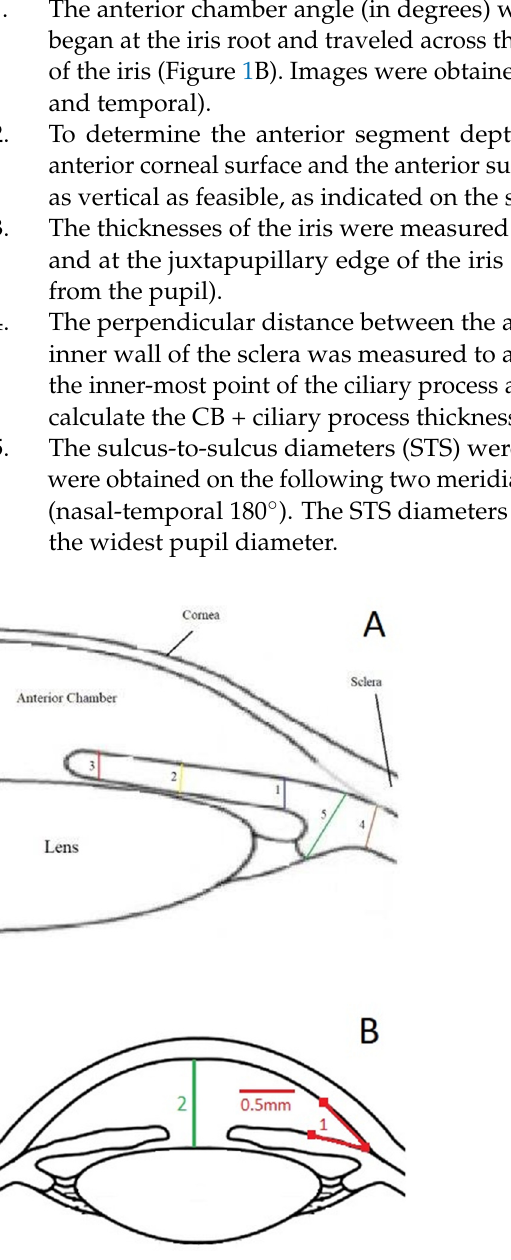
Figure 1. ( A ) This is an illustration of both the iris and the ciliary body, as seen by ultrasound biomicroscopy (UBM) in this study. The blue line (1) represents the iris thicknesses at 0.8 mm distance from the root of the iris. The yellow line (2) represents the iris thickness halfway down the radial length of the iris. The red line (3) represents the iris thickness at the juxtapupillary edge. The blue line (4) represents the thickness of the ciliary body, and the green line (5) represents the thickness of the ciliary body and the ciliary processes. ( B ) The red line (1) represents the anterior chamber angle, and the green line (2) represents the anterior segment depth, all as described in the methodology section.